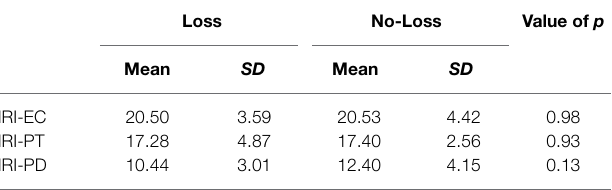
TABLE 1 | Group comparison of dispositional